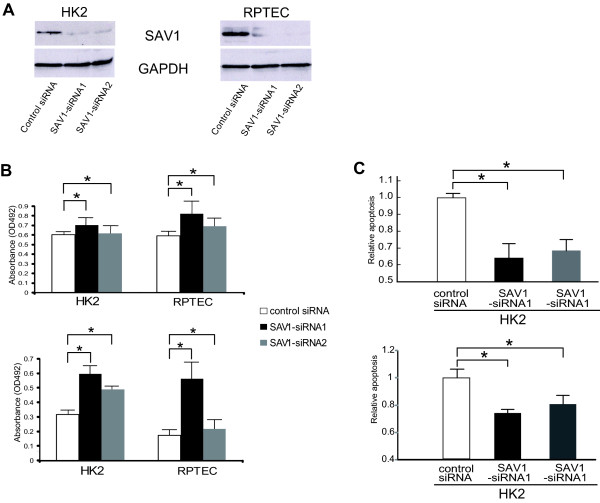
Knockdown of SAV1 induces cell proliferation and inhibits apoptosis. a Expression of SAV1 protein was suppressed in HK2 cells and RPTEC transfected with specific siRNAs. Two independent Stealth™ RNAi oligonucleotides for SAV1 (SAV1-siRNA1 and SAV1-siRNA2), or the Stealth™ RNAi Negative Control Duplex siRNAs (control-siRNA) were transfected into HK2 and RPTEC cells. After 72 h, protein was extracted and analyzed by Western blotting with anti-SAV1 antibody and anti-GAPDH antibody. SAV1 was markedly downregulated in HK2 and RPTEC cells transfected with SAV1-siRNA1 and SAV1-siRNA2. b Knockdown of SAV1 induces proliferation of HK2 cells and RPTEC. Upper column; MTS assay at 72 h after transfection. Y axis indicates the absorbance at 492 nm for MTS assay. Experiments were performed in triplicate, and bars indicate s.d.. * p < 0.05; Student's t test. Lower column; BrdU incorporation was estimated as the absorbance of cells transfected with SAV1-siRNA1 and SAV1-siRNA2, and those transfected with control siRNA. Experiments were performed in triplicate, and bars indicate s.d.. * p < 0.05; Student's t test. MTS assay as well as BrdU incorporation demonstrated that proliferation of HK2 cells and RPTEC transfected with SAV1-siRNA1 and SAV1-siRNA2 was significantly increased relative to cells transfected with control siRNA. c Apoptotic activity after transfection with SAV1 siRNAs was significantly inhibited. Upper column; HK2 cells transfected with control siRNA, SAV1-siRNA1 and SAV1-siRNA2 were incubated for 72 h and then analyzed using a cell death ELISA kit. Y axis indicates the relative ratio of the absorbance at 492 nm for control cells set at 1.0. The results are shown as means ± s.d. of three independent experiments. * p < 0.001; Student's t test. Lower column; HK2 cells transfected with control siRNA, SAV1-siRNA1 and SAV1-siRNA2 were incubated for 72 h and then analyzed using a Caspase-Glo 3/7 Assay kit. Y axis indicates the relative ratio of the fluorescent signal for control cells set at 1.0. The results are shown as means ± s.d. of three independent experiments. *p < 0.001; Student's t test.